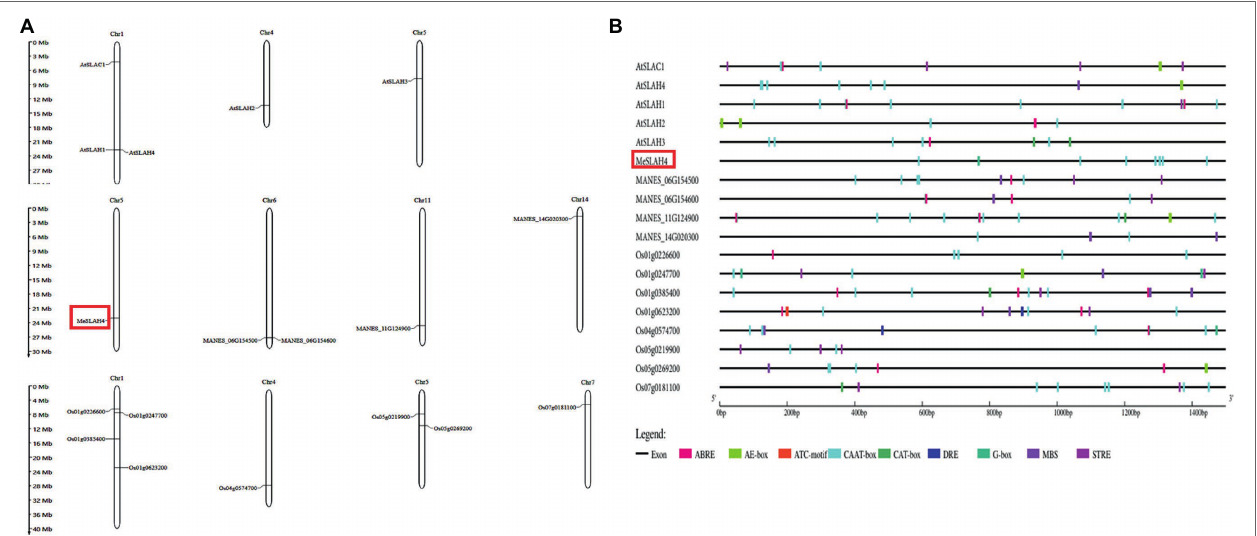
FIGURE 2 | Chromosomal localization and cis -elements analysis. (A) Chromosome localization of SLAH genes in Arabidopsis thaliana (At), Manihot esculenta (MANES), and Oryza sativa (Os). The approximate positions of the SLAH genes are presented on the respective chromosome size. (B) Cis -elements in the promoter regions (2.0-kb upstream regions) of the SLAH genes in Arabidopsis , cassava, and rice. Different colors represent various types of cis -elements, including core promoter elements, light responsive, phytohormone responsive, abiotic stress responsive and others related to growth. ABRE (ABA-responsive elements); E-box (enhancer box); CCAAT box/CAAT box/CAT box (GGCCAATCT consensus sequence); DRE (DNA Replication-related Element); G-box (G - box sequence, CACGTG); MBS (multichain binding site); STRE (stress-responsive